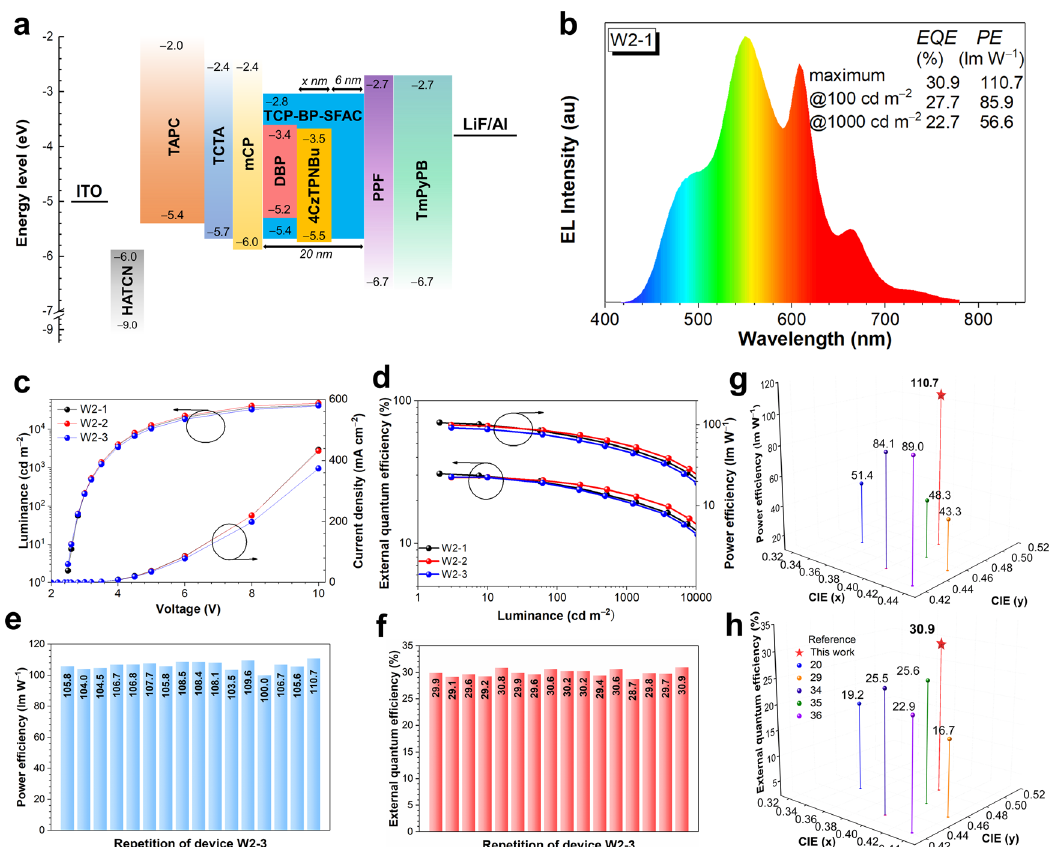
Fig. 4 | Device data and EL performance of three-color WOLEDs. a Device con- fi guration of all- fl uorescence three-color WOLEDs. b EL spectra of W2-1 at 1000cdm − 2 . c External quantum ef fi ciency-luminance-power ef fi ciency curves of W2-1 – W2-3. d Luminance-voltage-current density curves of W2-1 – W2-3. e , f Power